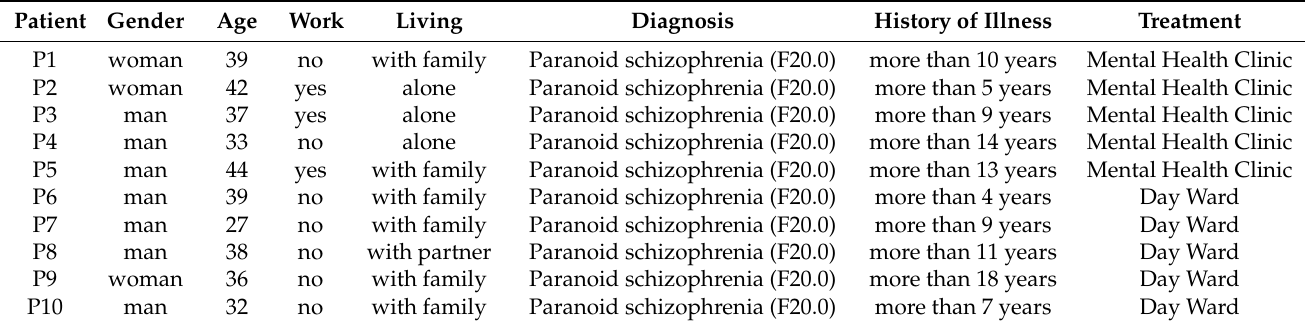
Table 2. Sociodemographic characteristics of the study